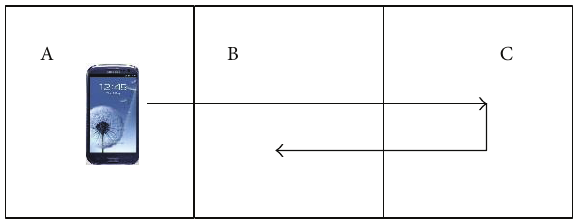
Figure 1: Movement of a